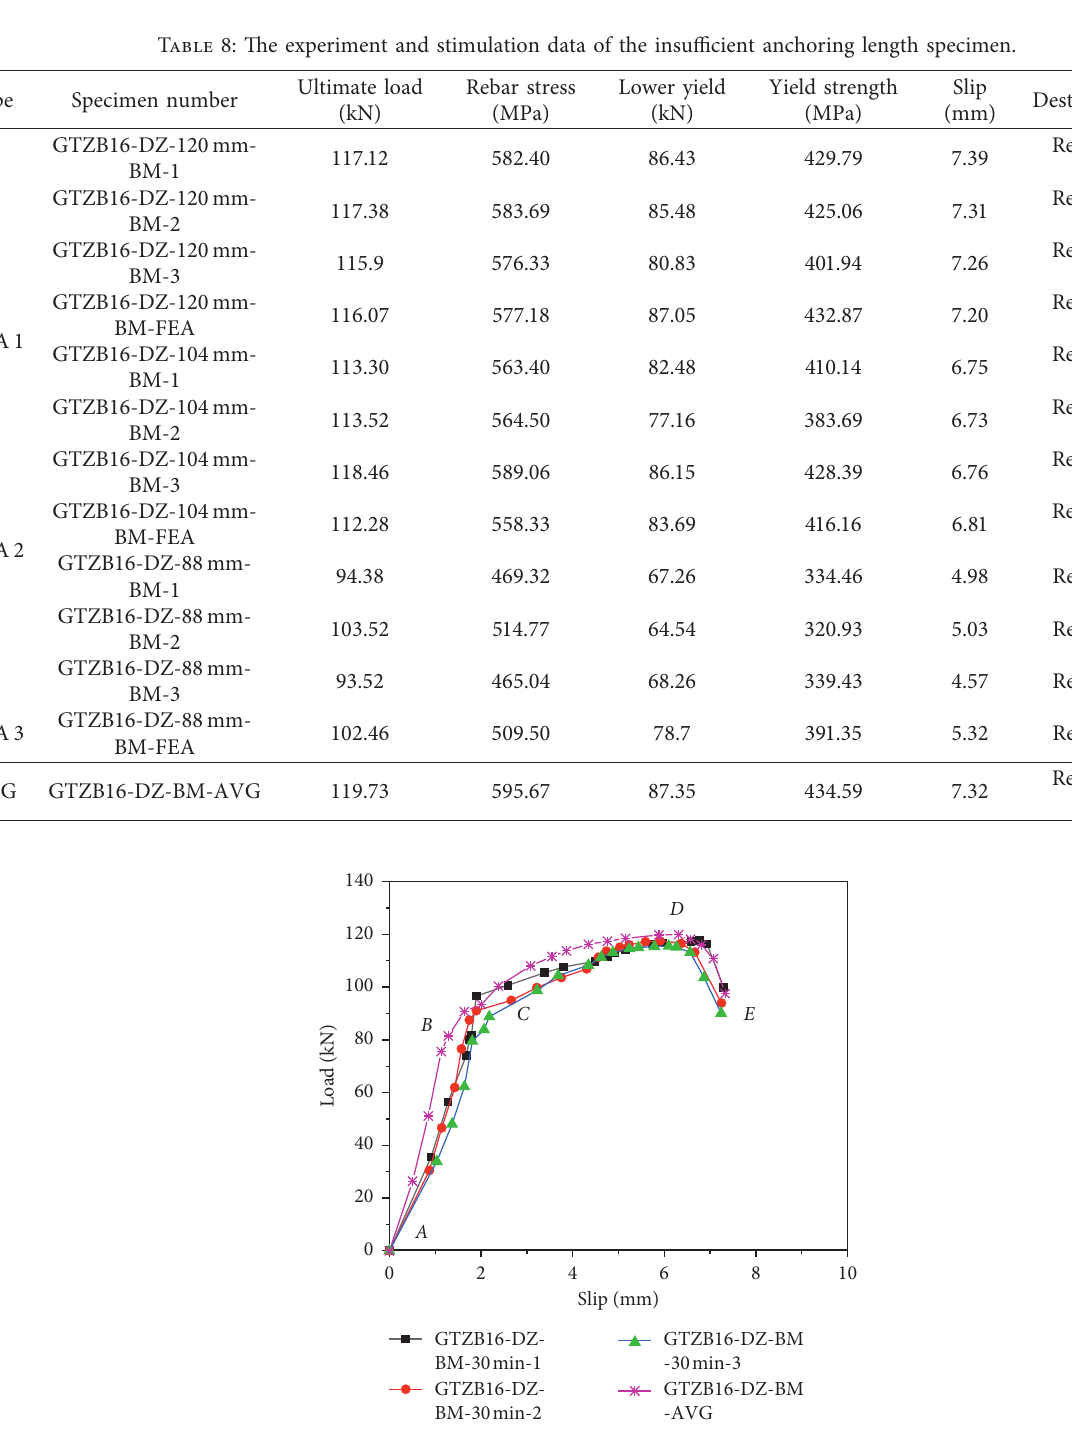
Figure 18: The load-slip curves of overtime grouting specimens (AVG: average